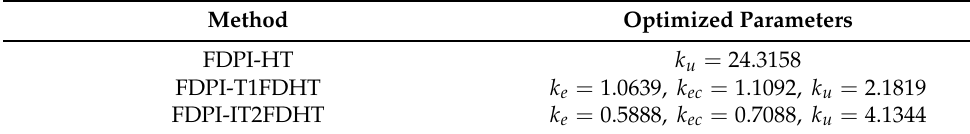
Table 7. Optimization results of three methods under no-load